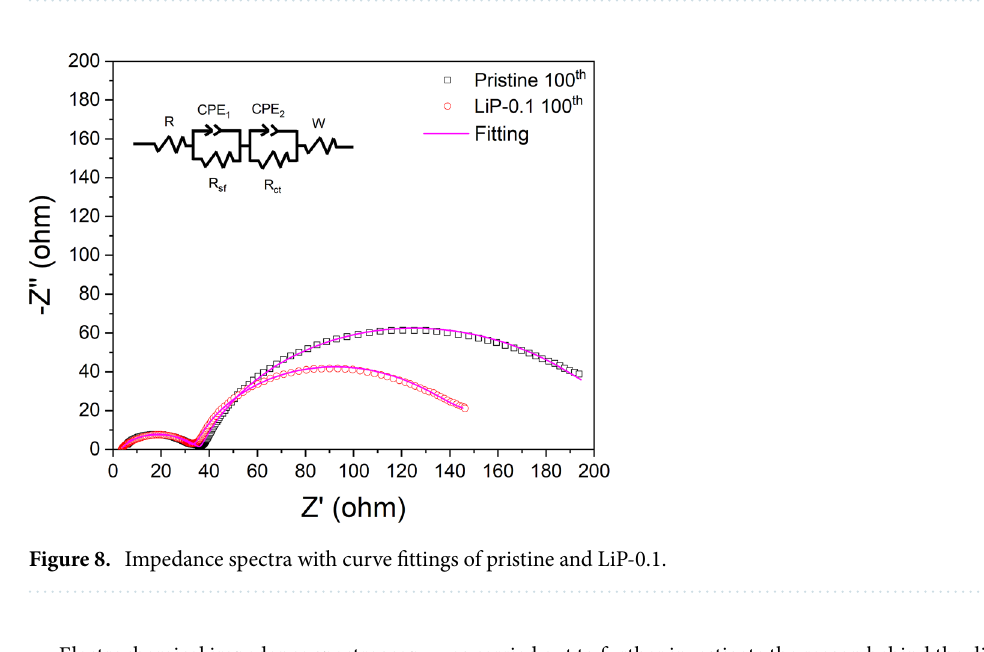
Figure 7. Cyclic Voltammograms of pristine and LiP-0.1.